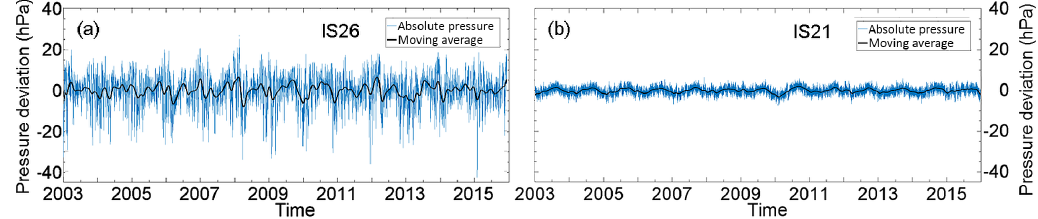
Figure A1. Absolute surface pressure data of MERRA-2 at IMS stations IS26 (a) and IS21 (b) as deviations from the annual means. The moving average highlights the superordinate annual variation. See also Fig. 4.